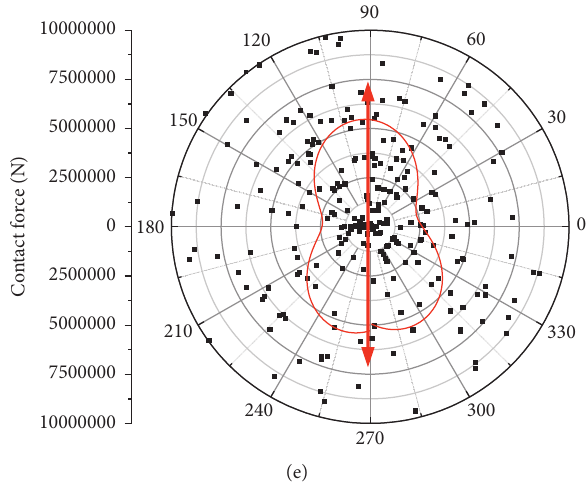
Figure 9: Fitting of the sizes and azimuth of the force chains in the key areas of the surrounding rock masses along the working face. (a) Location A. (b) Location B. (c) Location C. (d) Location D. (e) Location E.